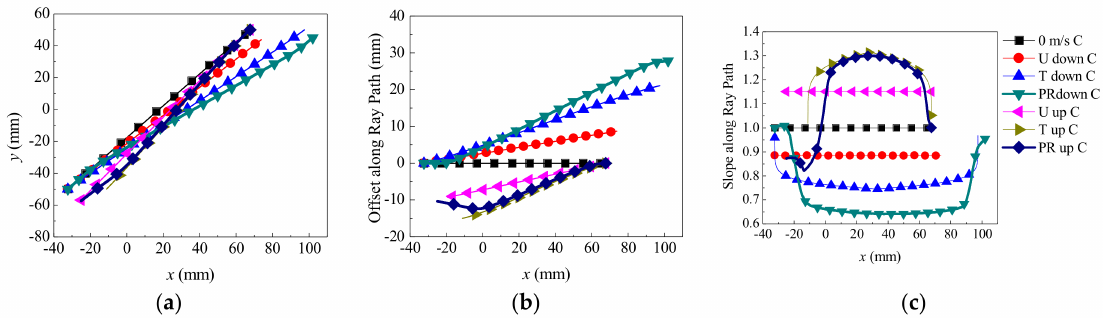
Figure 9. Propagation features of the central ray in different flow patterns ( v = 31.86 m/s). ( a ) Central ray propagation path. ( b ) Offset al.ong the central ray ( ∆ l Cpath ). ( c ) Slope along the central ray ( ∆ s Cpath